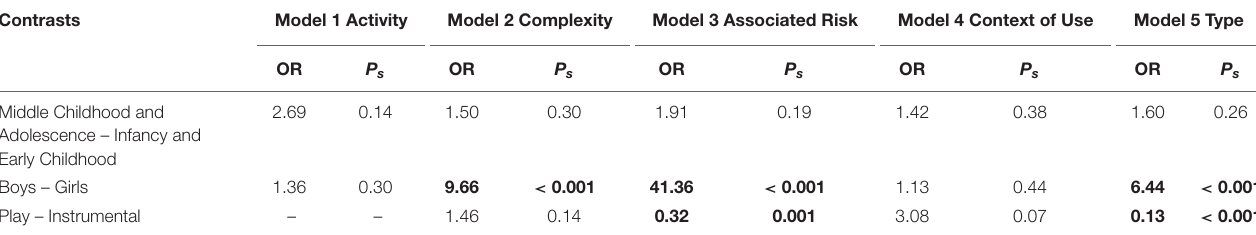
TABLE 2 | Contrasts reported as odds ratios (OR) and the proportion of the posterior above 0 ( P s ). Contrasts